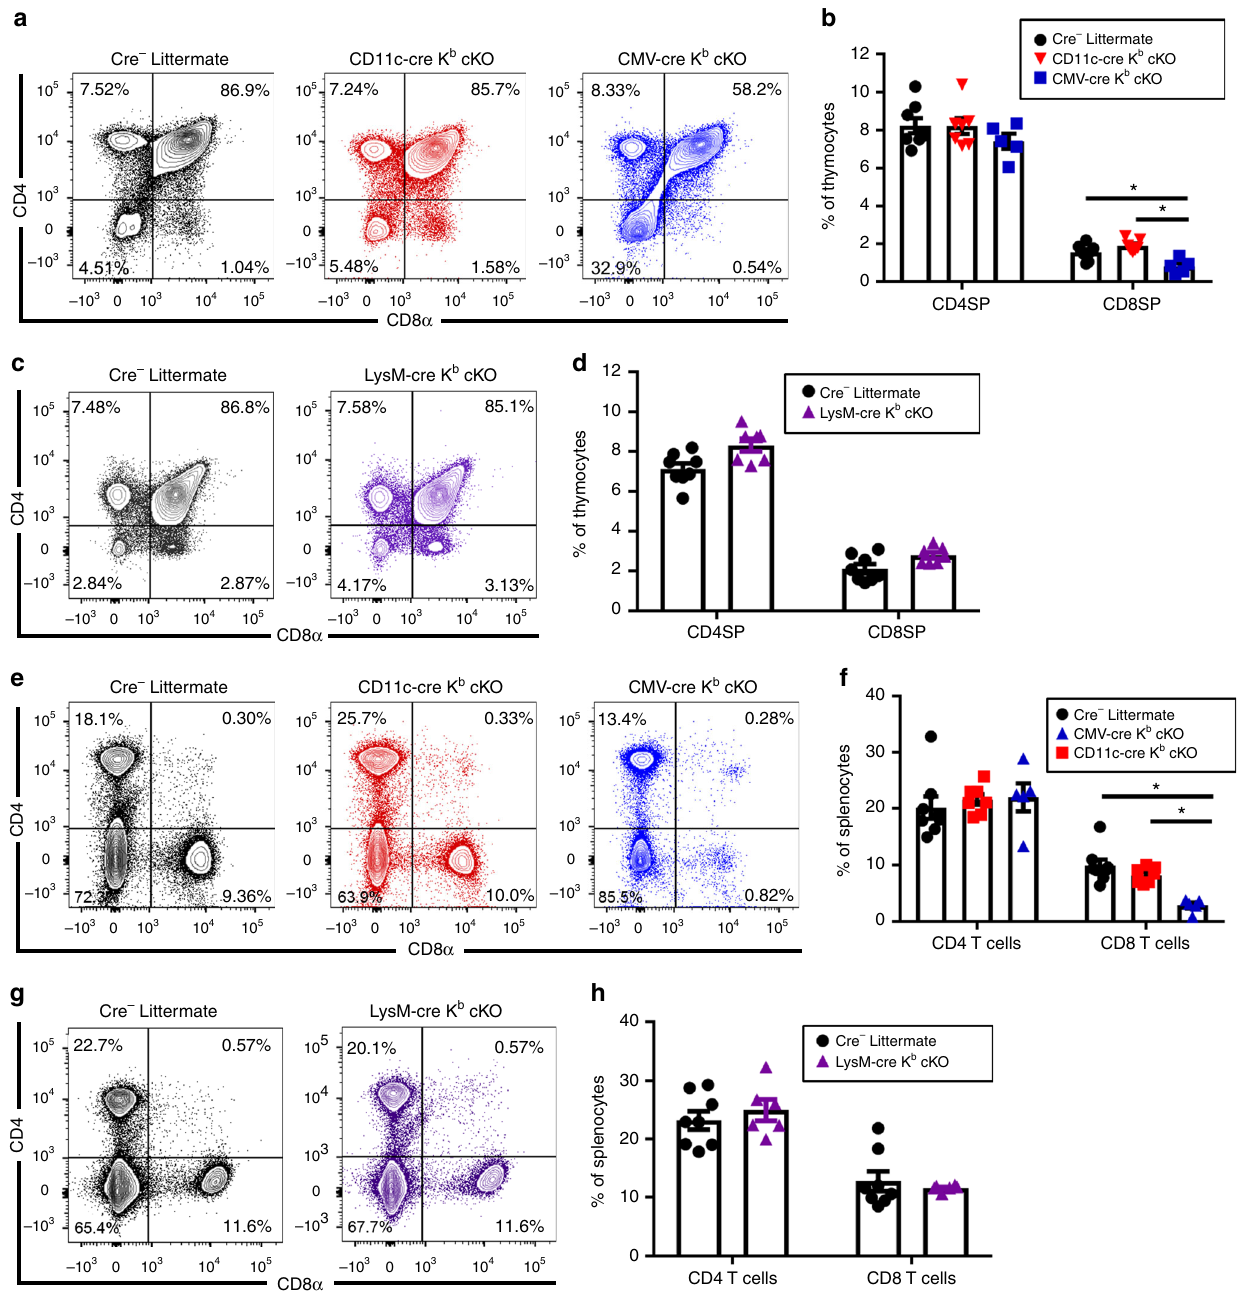
Fig. 2 Normal T-cell development in naive CD11c-cre and LysM-cre K b cKO mice. a Representative plots and b quanti fi cation show a block in thymocyte development only in CMV-cre K b cKO animals, but not CD11c-cre K b cKO animals ( N = 7, 8, 5 per group, respectively). c Representative plots and d quanti fi cation show no disruption of thymocyte development in LysM-cre K b cKO animals ( N = 8 and 7 per group, respectively). e Representative plots and f quanti fi cation show abnormal splenic CD8 + T-cell proportions in naïve CMV-cre K b cKO animals, but not CD11c-cre K b cKO animals. g Representative plots and h quanti fi cation show normal splenic T-cell populations in naïve LysM-cre K b cKO animals. Data presented as mean with error bars representing standard error of the mean (SEM). * denotes p < 0.05 by Mann − Whitney U Test or one-way ANOVA with Holm − Sidak − brain barrier permeability, CD11c-cre K b cKO animals were results in a CD8 + T-cell response capable of inducing fatal blood − brain barrier disruption as a result of P . berghei ANKA fully protected from ECM with 100% of animals surviving (Fig. 5d). Conversely, LysM-cre K b cKO and cre-negative infection. littermate controls succumbed to ECM between days 6 and 7 post challenge, similar to wild-type C57BL/6 mice (Fig. 5d). These results demonstrate a role for both dendritic cells and macro- K b deletion impairs CD8 + T-cell responses to TMEV infection . phages in generating a CD8 + T-cell response to P . berghei ANKA We next assessed the capacity for CD8 + T-cell priming during infection. However, only antigen presentation by dendritic cells acute brain infection with recombinant TMEV encoding the